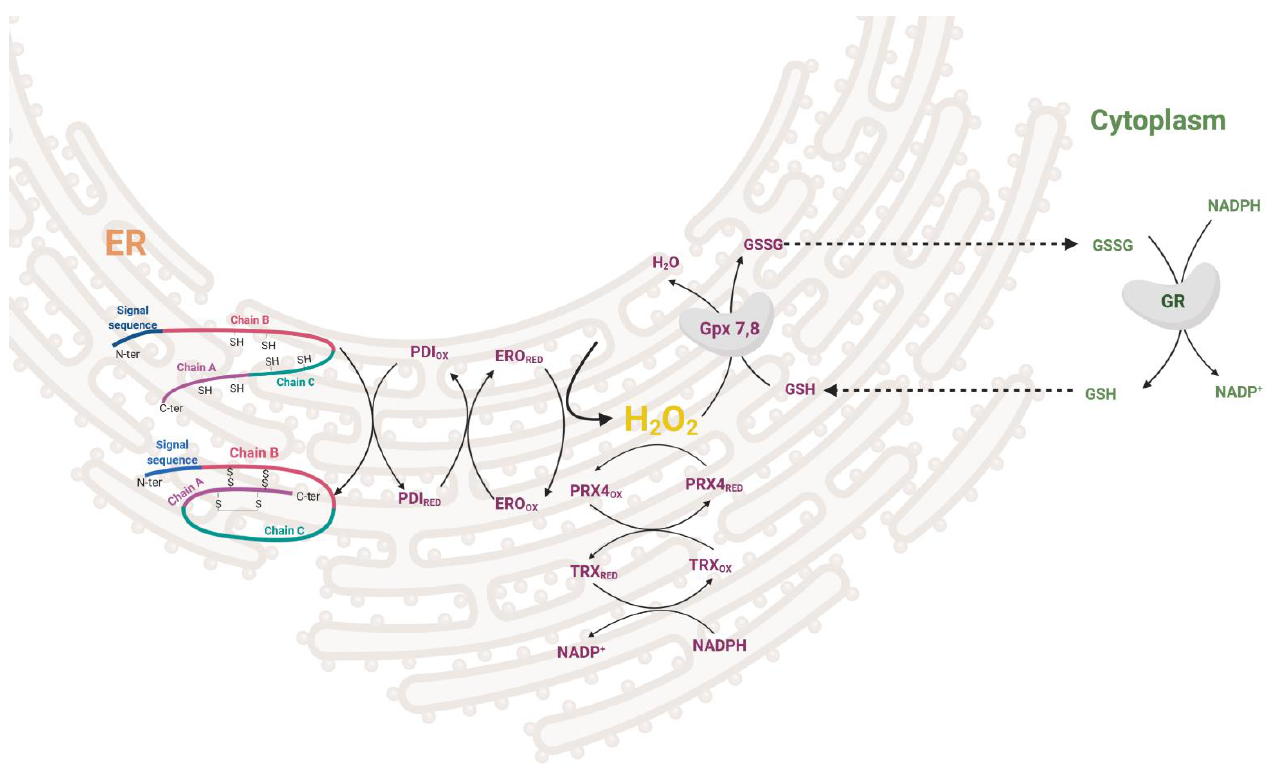
Figure 2. Redox regulation in ER during proinsulin folding. Disulfide bonds are formed by disulfide isomerase (PDI) together with ER oxidoreductin (ERO) oxidoreductases while giving rise to H 2 O 2 . This can be attenuated by PRX4/TRX or GPX7,8/GSH redox couples in conjunction with cytosolic redox status. PDI—disulfide isomerase, ERO—ER oxidoreductin, PRX—peroxiredoxin, TRX—thioredoxin, GPX—glutathione peroxidase, GSH—glutathione.